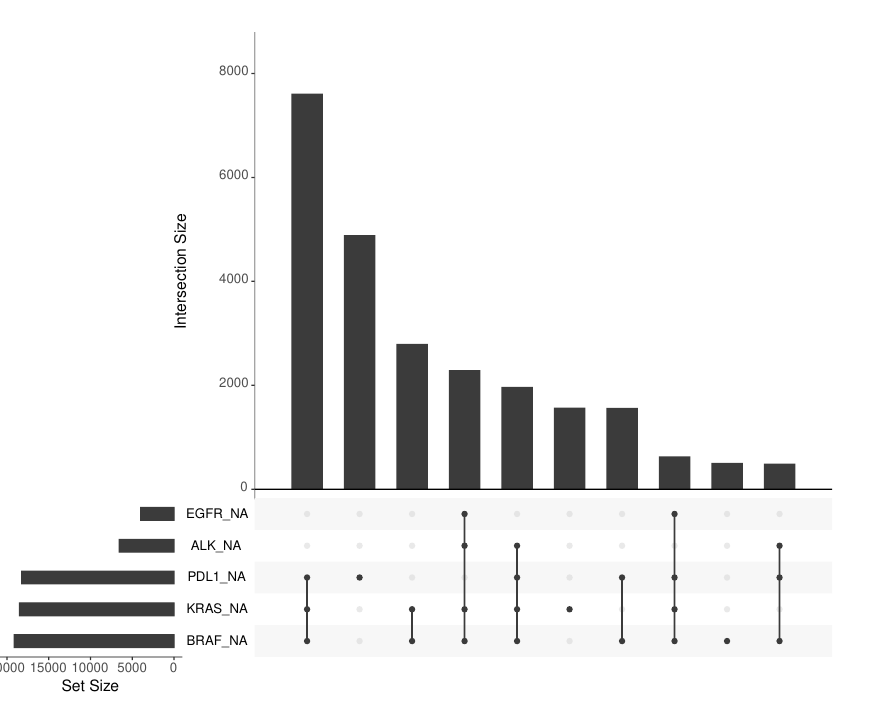
Figure 1. Biomarker status missingness and its combinations of missingness using the intersecting sets visualisation method